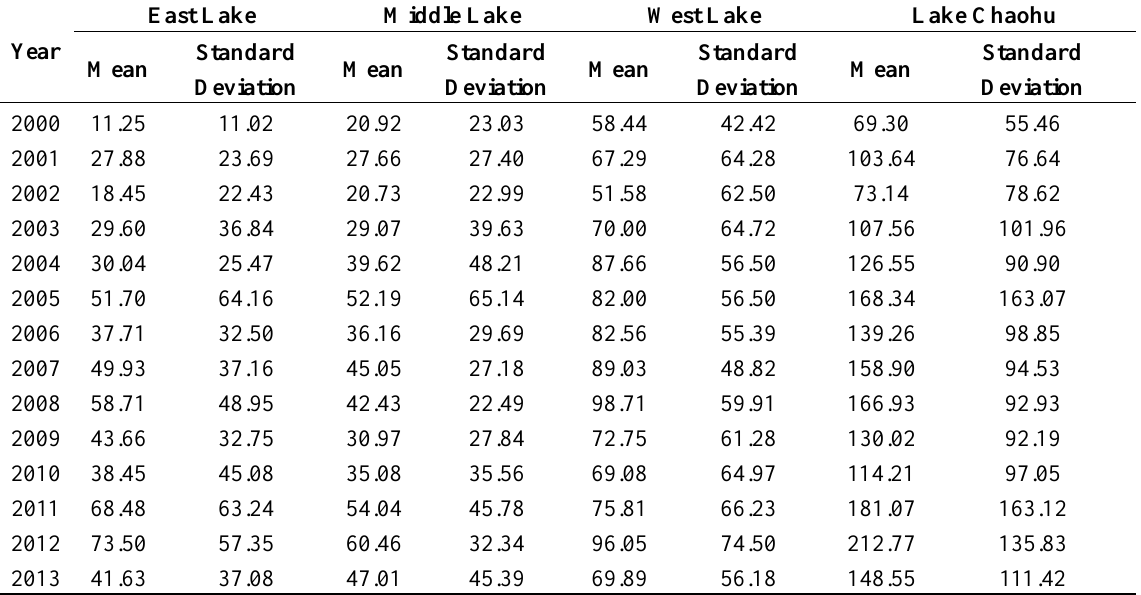
Table 2. Mean and standard deviation of monthly maxima of floating algae bloom area in each lake segment of Lake Chaohu *